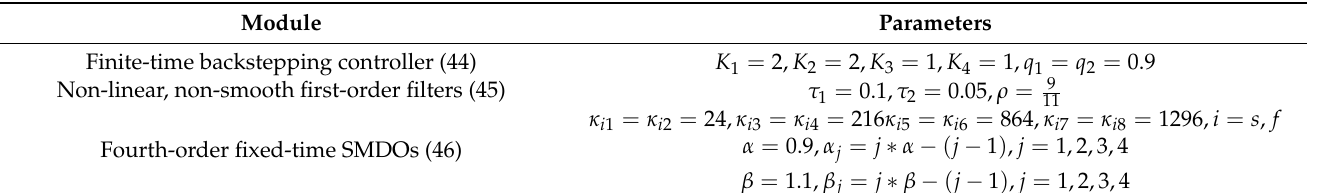
Table 3. NBC Controller parameters.